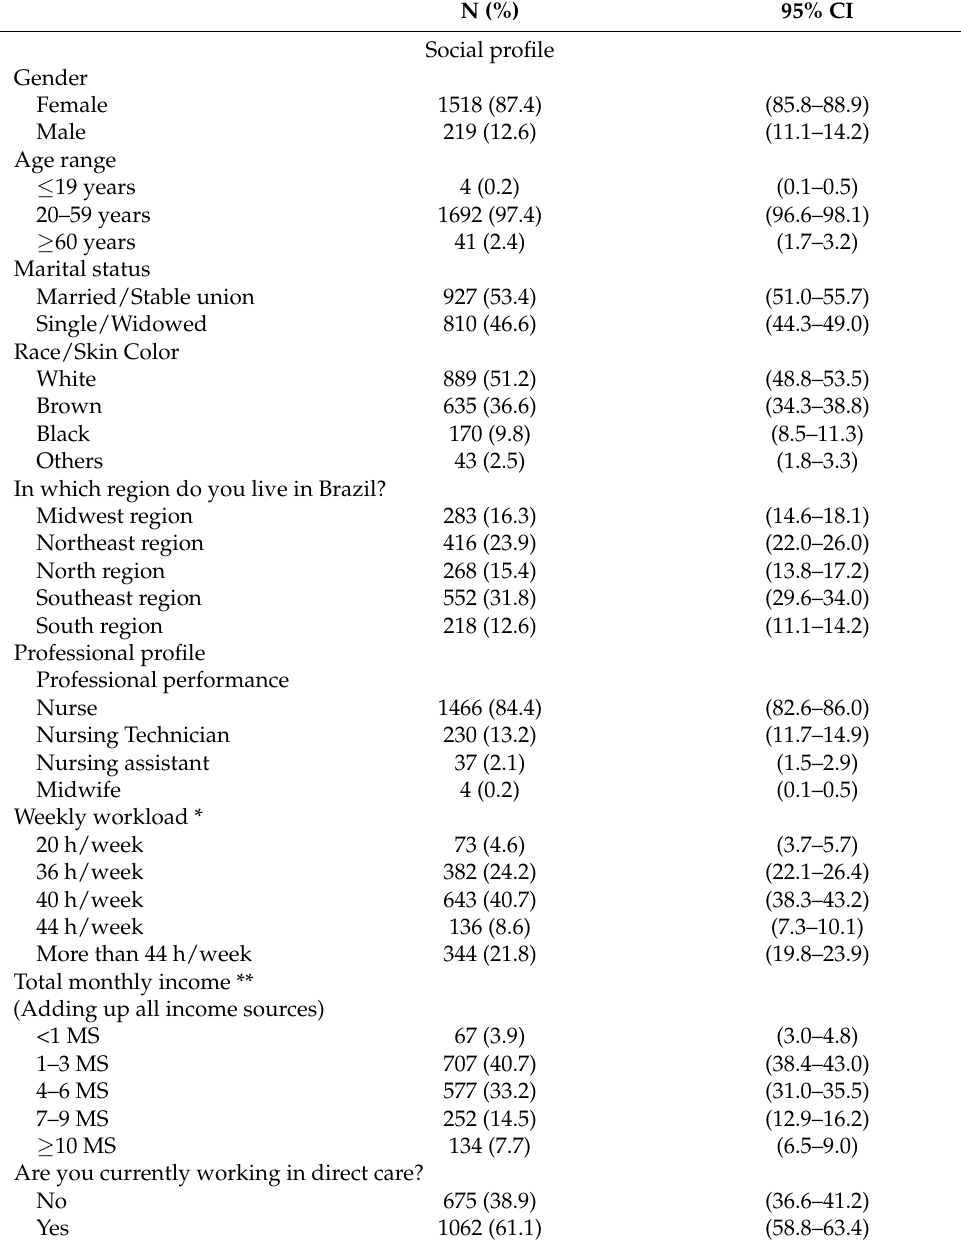
Table 1. Social and professional profile of the sample of nursing professionals (n =